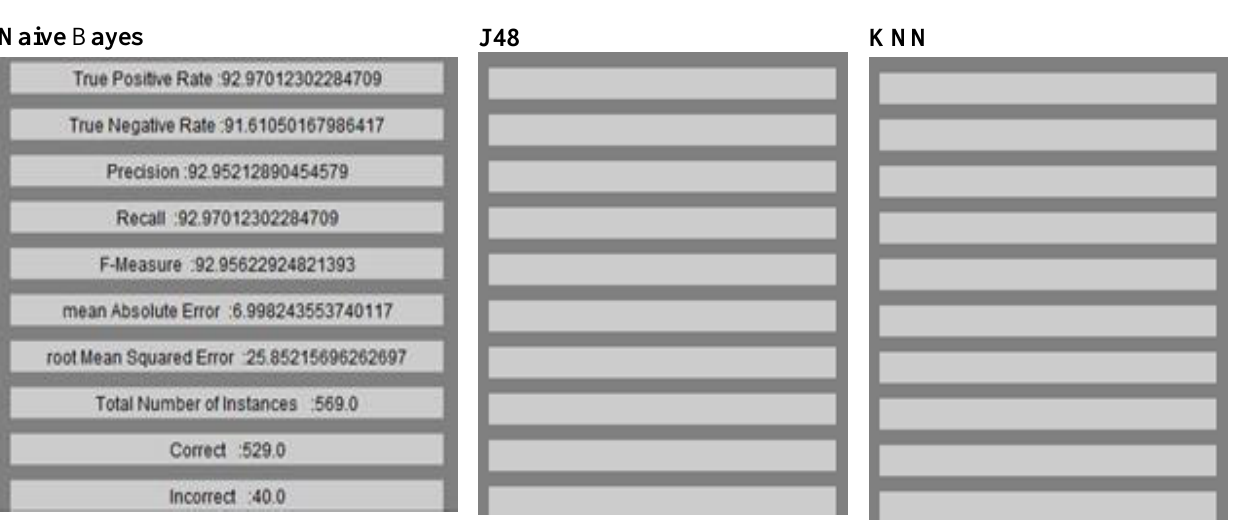
Figure 3. NB classifier description